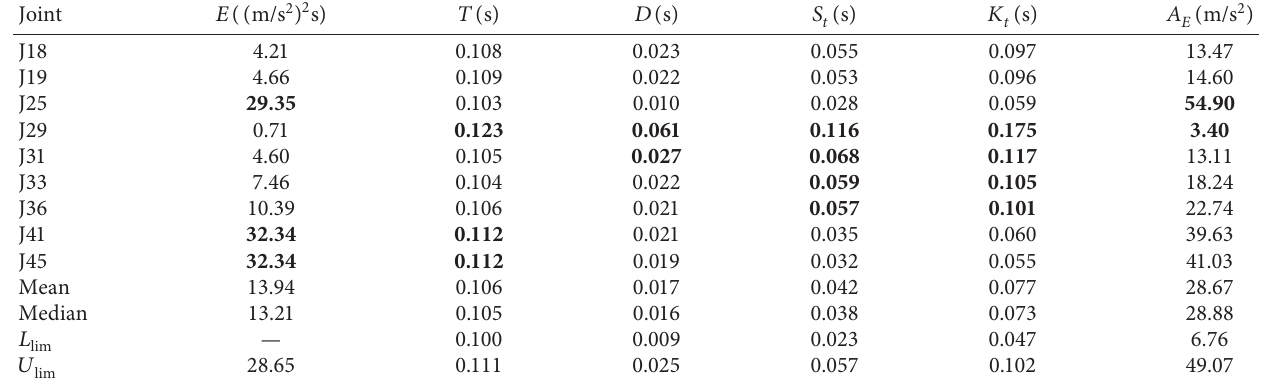
Table 2: Detailed results of the statistical parameters for relevant joint connections.